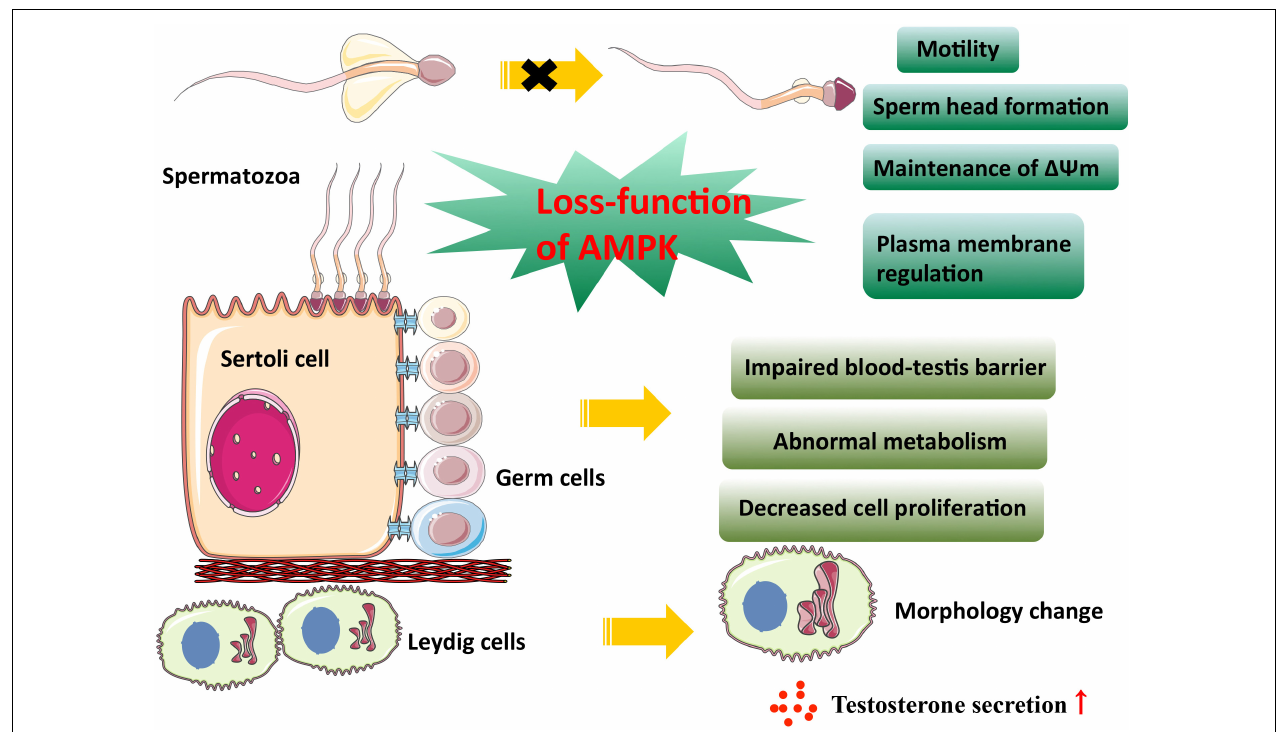
FIGURE 2 | AMPK activity in male reproduction. This figure summarizes the effect of AMPK on male gonadal somatic cells and spermatogenesis. As is shown above, the loss-function of AMPK leads to the impaired physiological function of somatic cells and